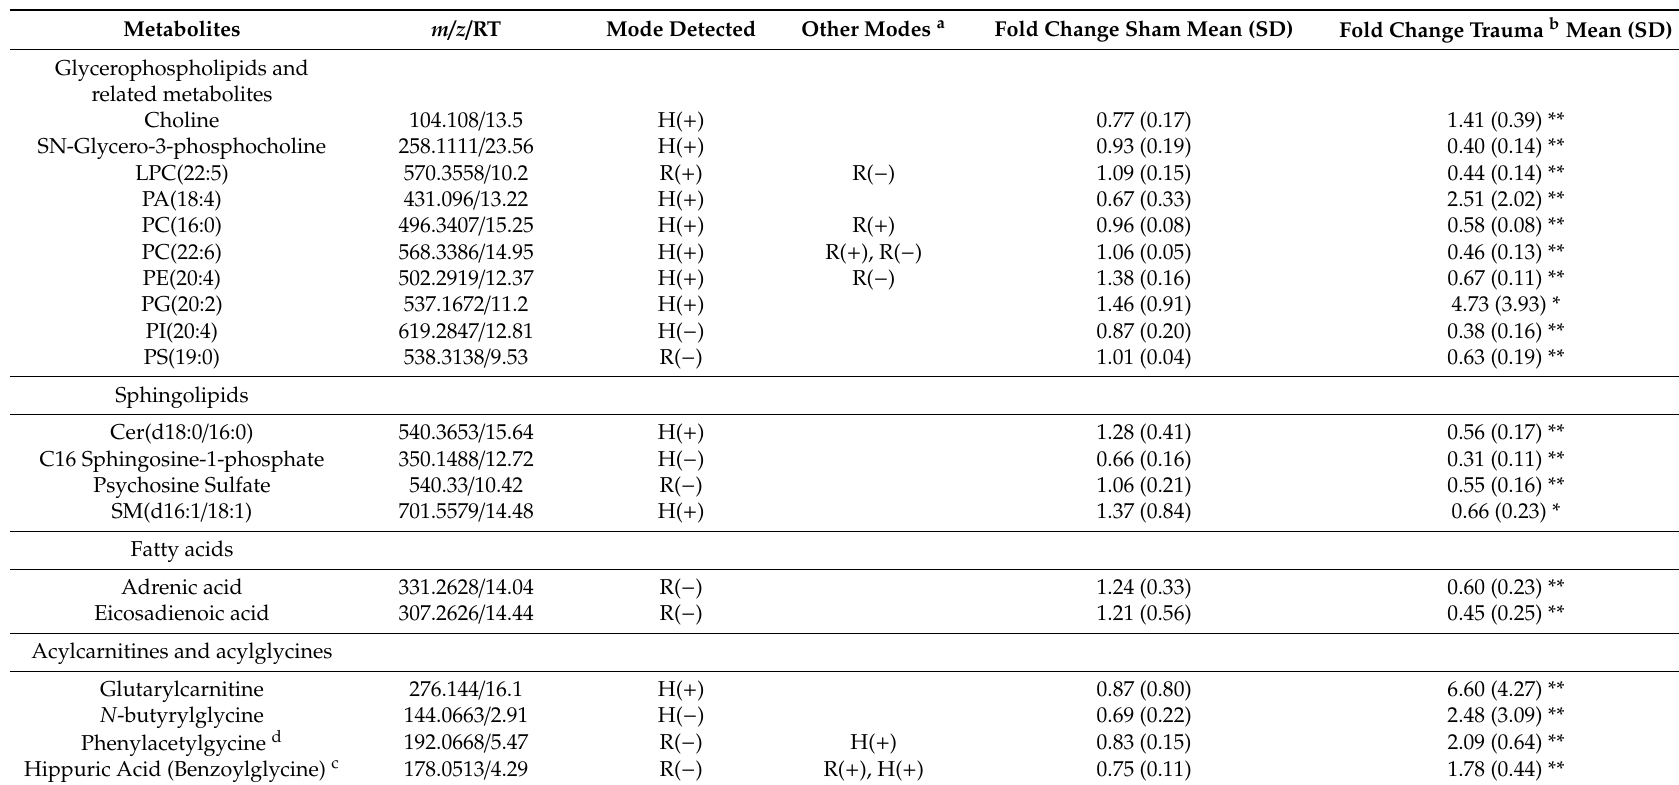
Table 2. Representative di ff erentiating metabolites identified from LC-MS